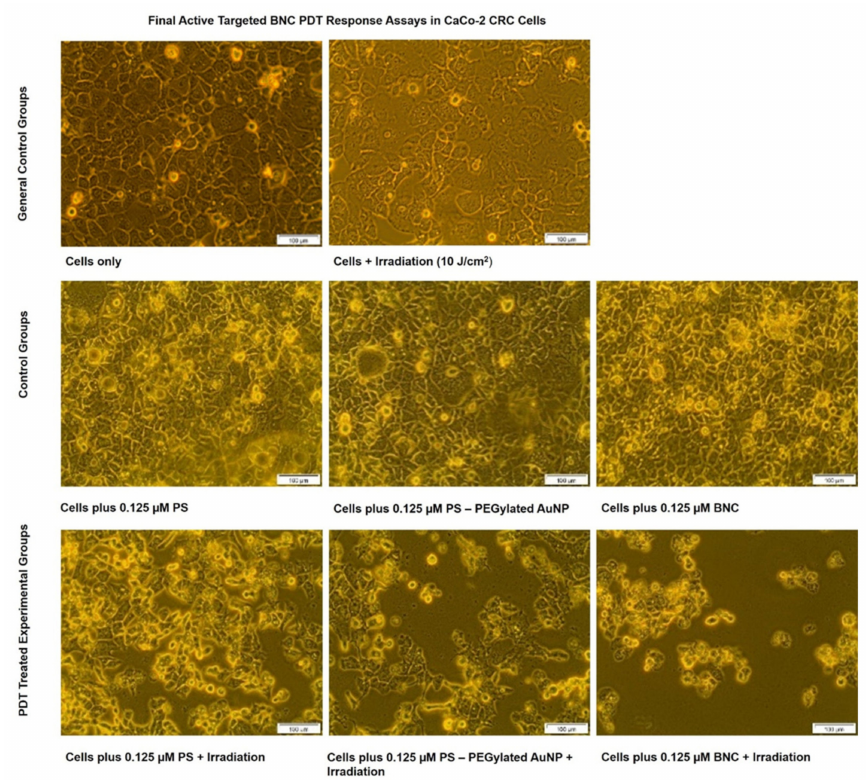
Figure 9. CaCo-2 CRC cells’ morphological comparison of various control and experimental groups within final BNC PDT response